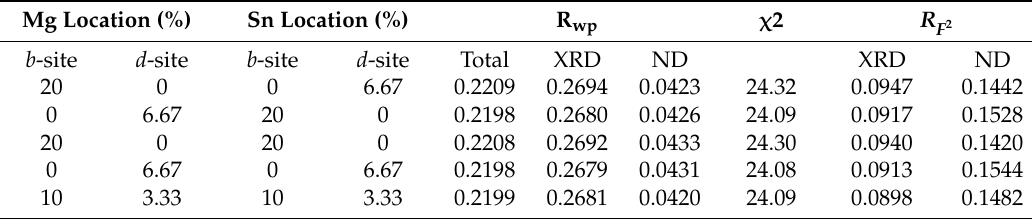
Table 1. Goodness of fit parameters for joint X-ray diffraction (XRD) and ND Rietveld refinement